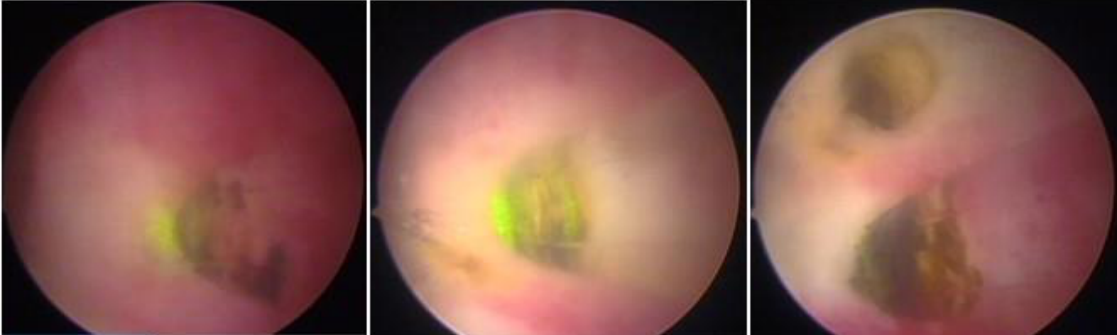
Figure 12. LASER in submucous myoma with deep intramural component.